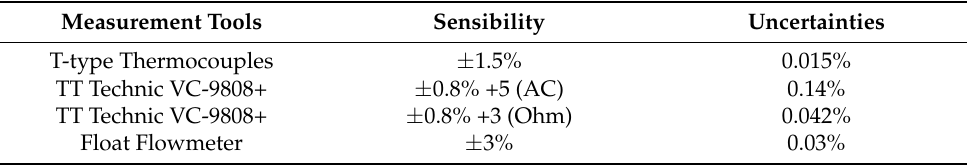
Table 4. Measuring equipment properties and sensitivities. Measurement